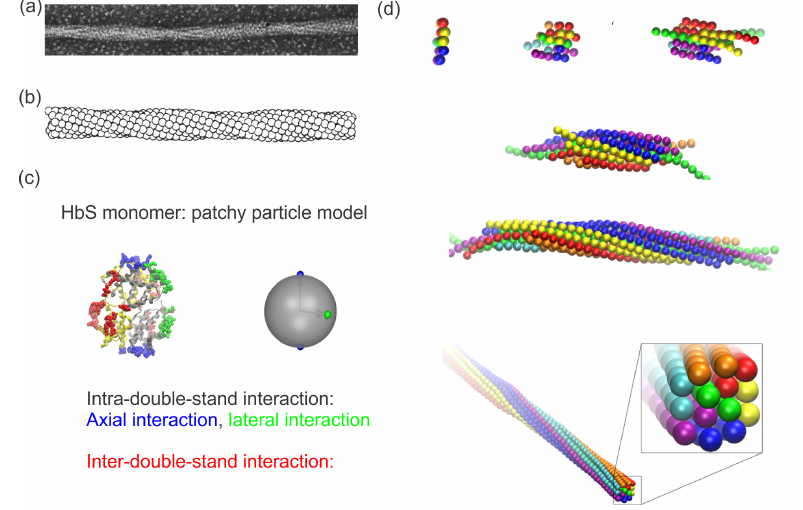
Figure 1. ( a ) Electronic microscopy image of structure of a single sickle hemoglobin (HbS) fiber. Reproduced with permission from reference [74]. ( b ) Reconstruction of the HbS fiber with a sphere model. Reproduced with permission from reference [74]. ( c ) Mesoscopic modeling of HbS molecules ( left ) by patchy particles ( right ). Green and blue represent lateral and axial intra-double-strand contacts. Red signifies the inter-double-strand contacts. Reproduced with permission from reference [81]. ( d ) Sequential snapshots of HbS polymerization from a nucleus to a fiber. Reproduced with permission from reference